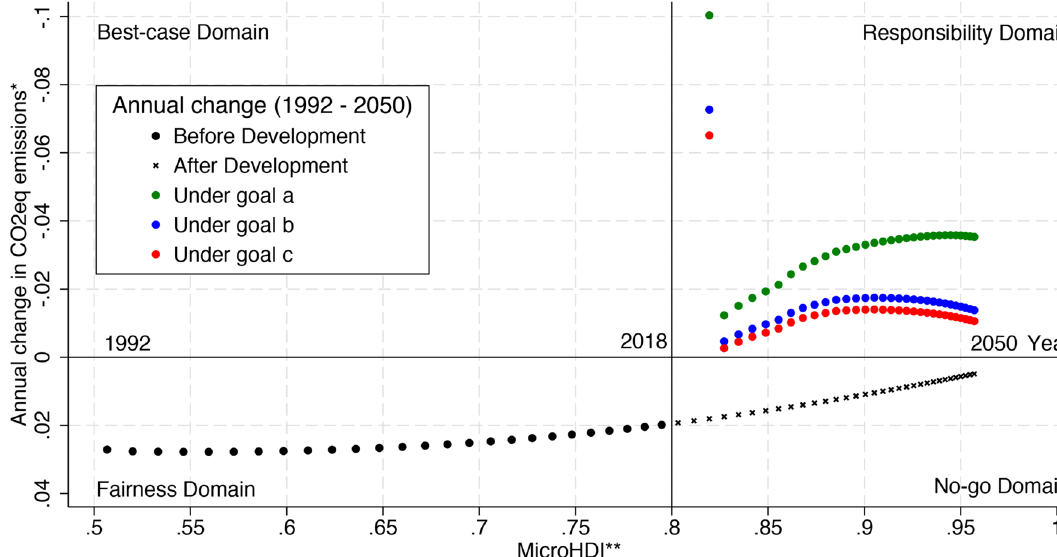
Fig. 5 CO eq emissions reduction framework based on MicroHDI for Brazil (1992–2050). MicroHDI in the figure represents an average of 2 each microregion MicroHDI weighted by its population in 2010 and considering the 436 microregions in the sample. Note that the y -axis is inverted, similarly to Costa and co-workers [12]. The vertical line indicates the human development threshold of 0.8 MicroHDI, representa- tive of very high development